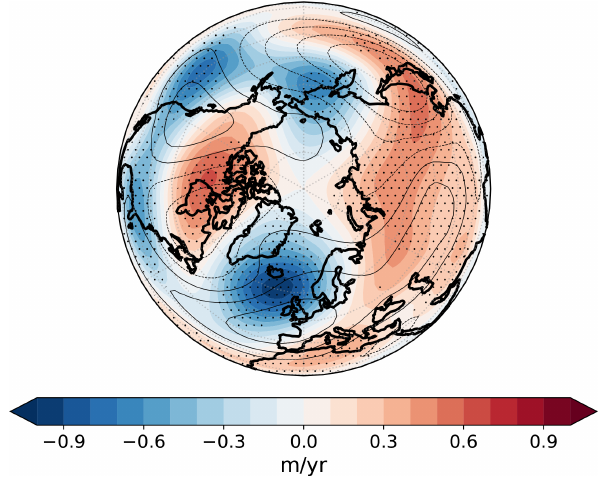
Figure 10. Multi-model average of the trends in the stationary ed- dies (shading) and multi-model mean of the stationary eddies for the historical simulations (contour). Hatching indicates where 80% of the models agree on the sign of change. The trend in the station- ary eddies is equivalent to the residual local trend after removing the global and zonal